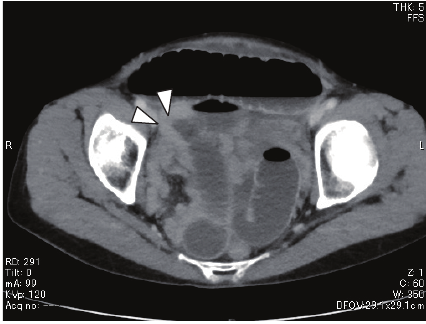
Figure 3: An intra-abdominal inspection showed an abnormal cord-like structure adhered to the ileum (arrowhead).